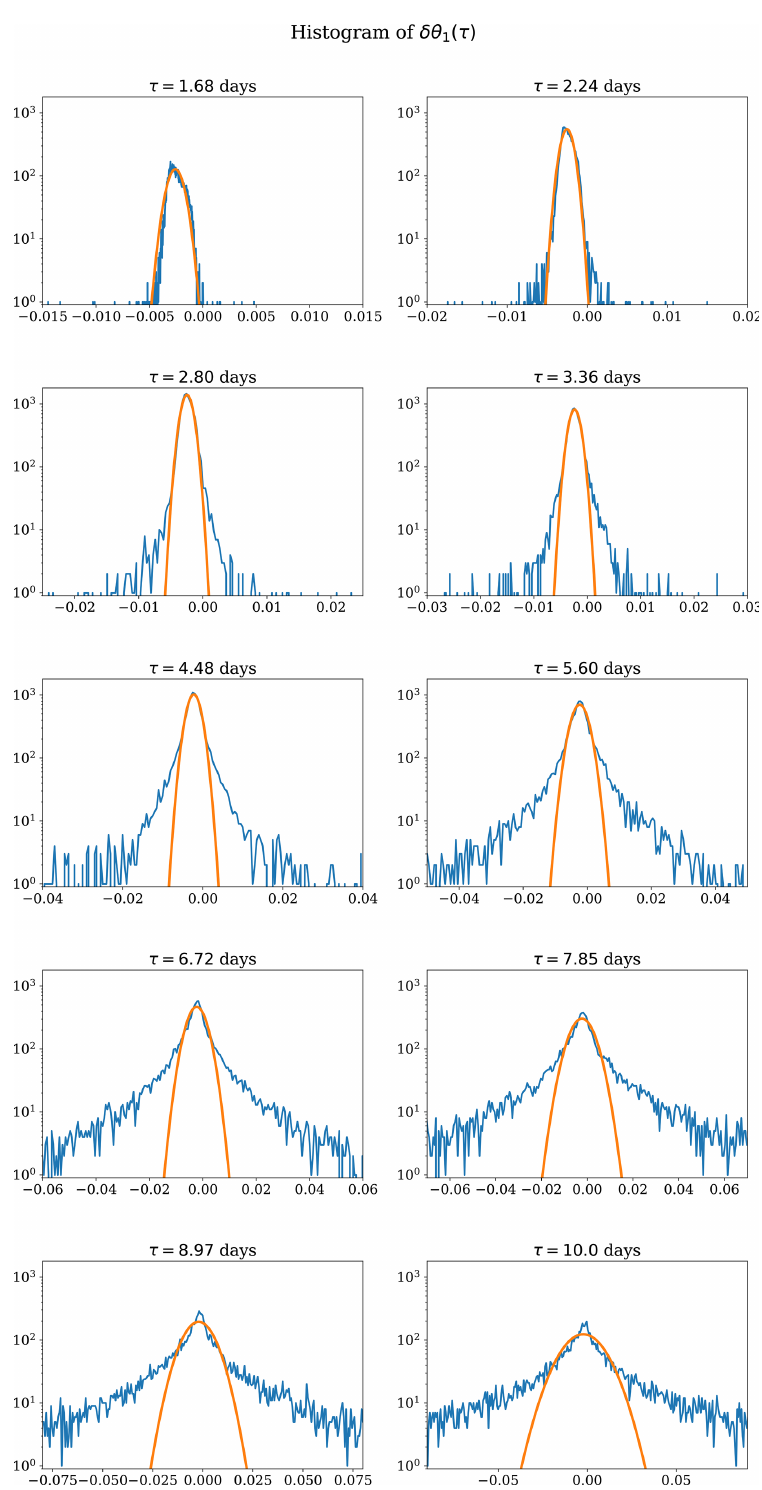
Figure 7. Histograms of the solutions δθ 1 (τ) of Eq. (50) for the perturbation δy (τ) (with θ 1 being the 11th component of y ) along the trajectories of model 0, for different values of the lead time τ . The solid orange curves are fits of a Gaussian distribution function to the different histograms. The fat-tail phenomenon described in Eyink et al. (2004) is apparent and becomes more prominent as the lead time